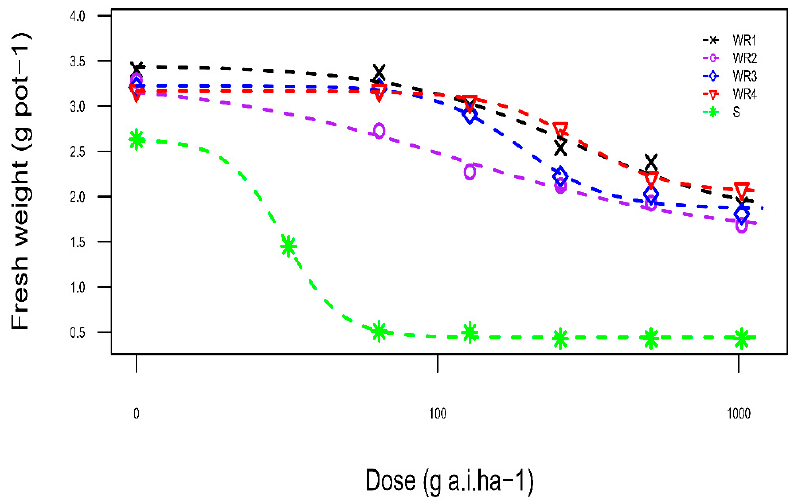
Figure 1. Effect of different concentrations of clodinafop- propargyl herbicide on aboveground fresh weight of susceptible and resistant biotypes. Symbols and lines represent actual and estimated response of resistant and susceptible biotypes, respectively. The symbols represent the mean of four replicates. The plants were grown in a greenhouse. Table 4. Parameter estimates (SE) of four-parameter log-logistic model and resistance indices (RI) from whole plant bioassay of the suspected resistance (WR 1 , WR 2 , WR 3 , WR 4 ) and susceptible (S) biotypes. Biotype